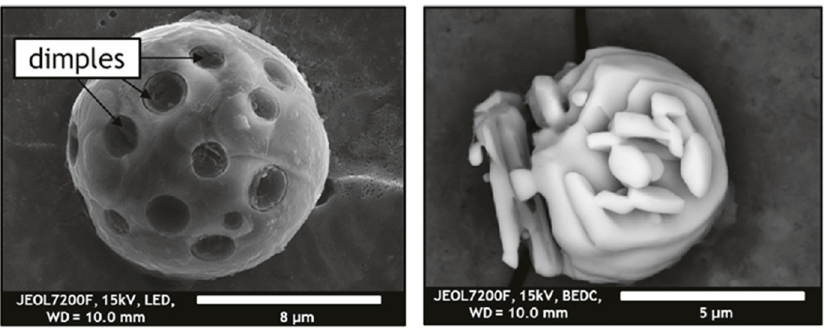
Figure 3. Oxide inclusions with missing sulphide regions which were dissolved after electrolytic extraction using the choline chloride solution. Adapted from the Ph.D thesis of Alexander Mayerhofer [68].